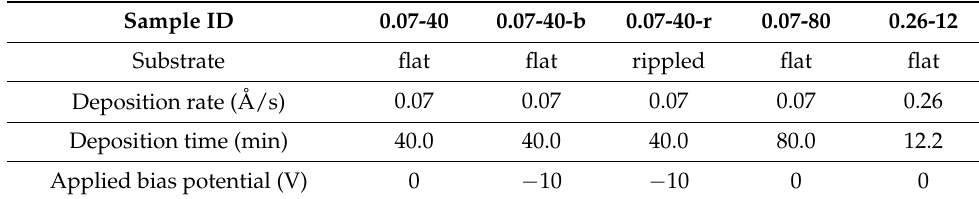
Table 1. Sample and thin film preparation